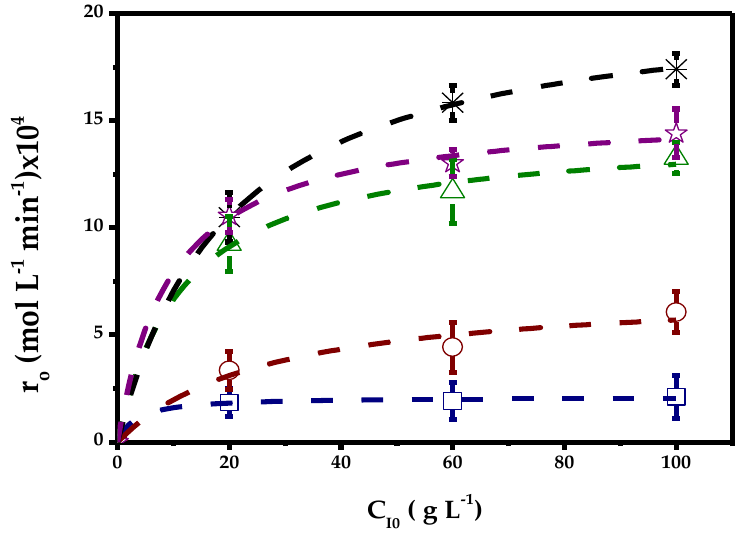
Figure 2. Effect of temperature on the initial rate of esterification to various initial concentrations of ibuprofen: 50 ( □ ), 60 ( Ο ), 70 ( Δ ), 75 ( ) and 80 °C ( ∗ ).